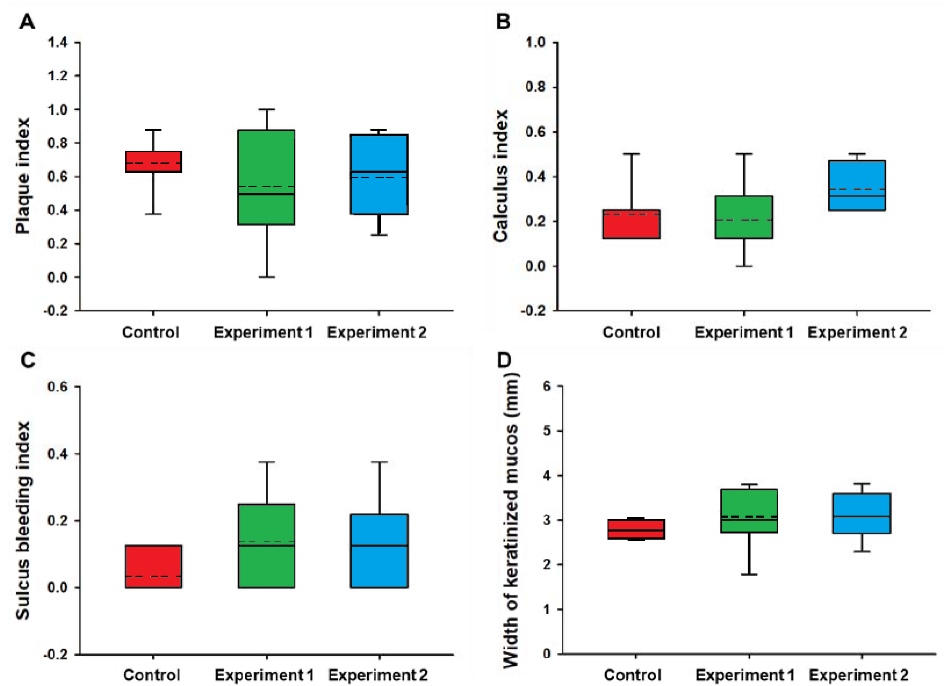
Figure 8. Box graph of peri-implant soft tissue parameters between the control, experiment 1, and experiment 2 groups at the 48-week follow-up. ( A ) Plaque index: score 0, no detection of plaque; score 1, plaque only recognized by running a probe across the smooth marginal surface of the implant; score 2, plaque can be seen by the naked eye; score 3, abundance of soft matter. ( B ) Calculus index: score 0, no detection of calculus; score 1, supragingival calculus covering ≤ 1 / 3 exposed tooth surface; score 2, supragingival calculus covering > 1 / 3 but < 2 / 3 tooth surface, flecks of subgingival calculus in cervical margin; score 3, supragingival calculus covering > 2 / 3 surface, continuous band of subgingival calculus. ( C ) Sulcus bleeding index: score 0, no bleeding when a periodontal probe is passed along the gingival margin adjacent to the implant; score 1, isolated bleeding spot visible; score 2, blood forms a confluent red line on margin; score 3, heavy or profuse bleeding. ( D ) Width of keratinized mucosa ( P = 0.668, 0.118, 0.079, 0.293, respectively, determined by the Kruskal–Wallis test).